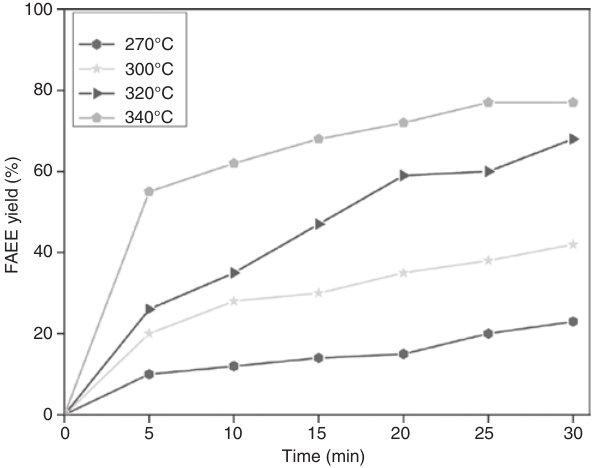
Figure 3: FAEE yield as a function of time at varied temperature.